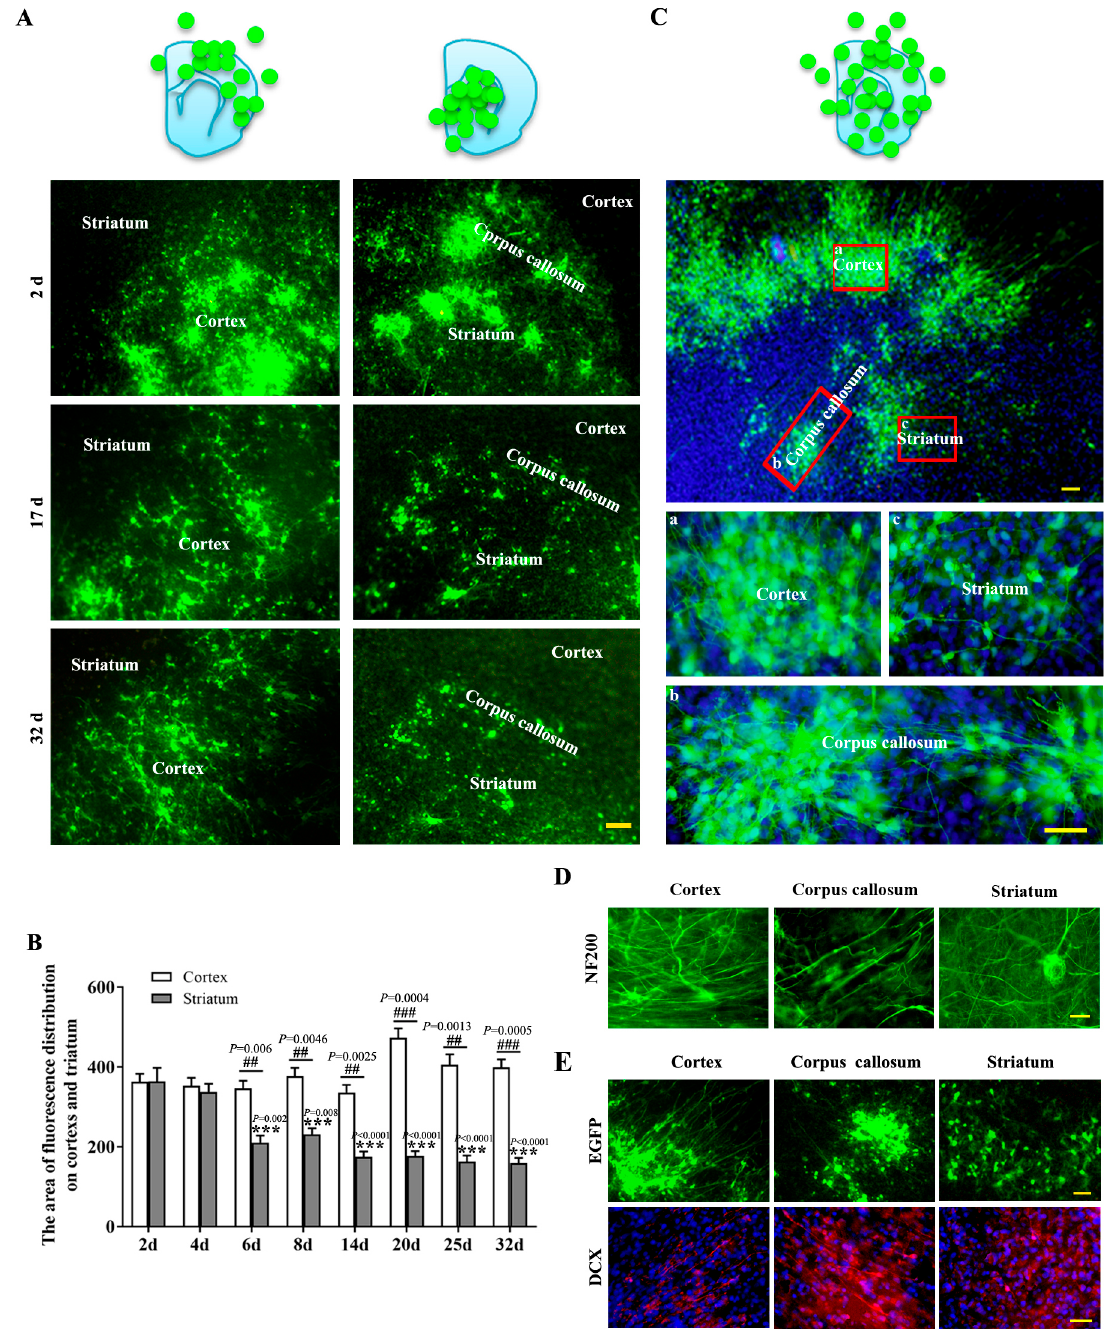
Figure 2. The survival and migration of transplanted NSCs on different part of host tissue. ( A ): The transplanted NSCs survived differently on cortex and striatum. Scalar bar = 50 µ m. ( B ): Statistical analysis was a two-way ANOVA (Df = 7, F = 6.914, p < 0.0001, for time; Df = 1, F = 238.2, p < 0.0001, for age. Df = 1, F = 6.864, p = 0.0108, for genotype; Df = 4, F = 3.384, p = 0.0228, for age), followed by Dunnett’s multiple comparisons test among different time points, and t -tests performed between cortex and striatum at the same time points. The values are mean ± SE, n = 5. ## p < 0.01, ### p < 0.001; *** p < 0.001 in comparison with striatum 2 d. ( C ): The migration of transplanted NSCs on cerebral cortex, striatum and corpus callosum. Red box: the zoomed-in region. (a) Cortex; (b) Corpus callosum; (c) Striatum. Scalar bar = 50 µ m. ( D ): The growth of neurites in cerebral cortex, striatum and corpus callosum. Scalar bar = 20 µ m. ( E ): The distribution and migration of transplanted NSCs in different brain regions. DCX2 + -nerve fibers of host neuron showed in red. Scalar bar = 50 µ